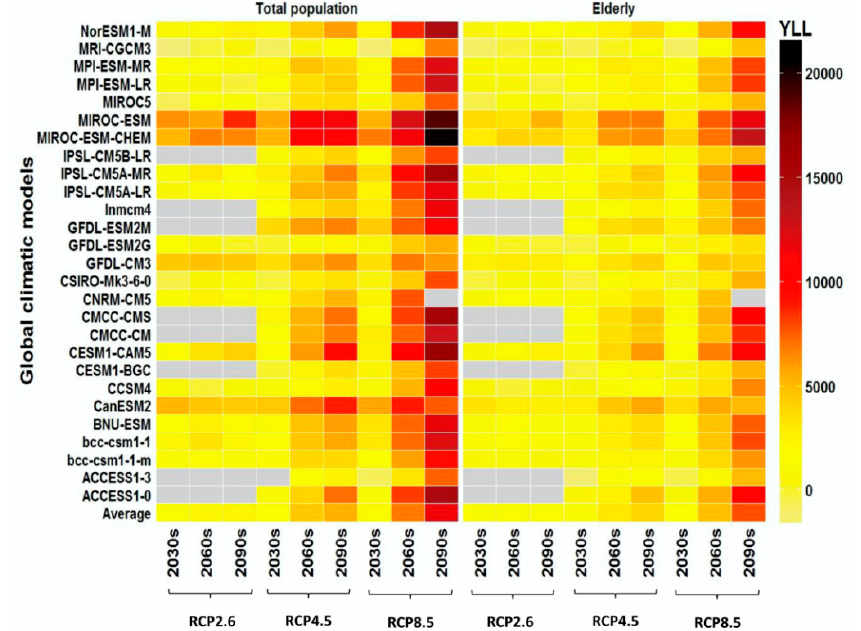
Figure 3. Annual heat-related YLLs in the total population and the elderly under different climatic scenarios. Note: The heat-related YLLs in the future have been subtracted by the heat-related YLLs in the 1980s. We assumed that the population size and their adaptation in the 21st century will remain constant at the 2010 level. Gray grids mean that the data were not available.